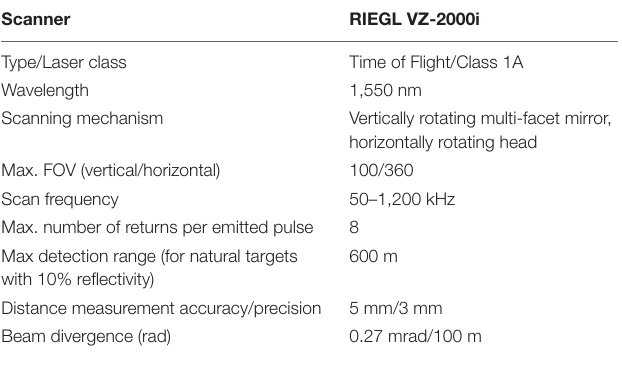
TABLE 1 | Technical specifications of the terrestrial laser